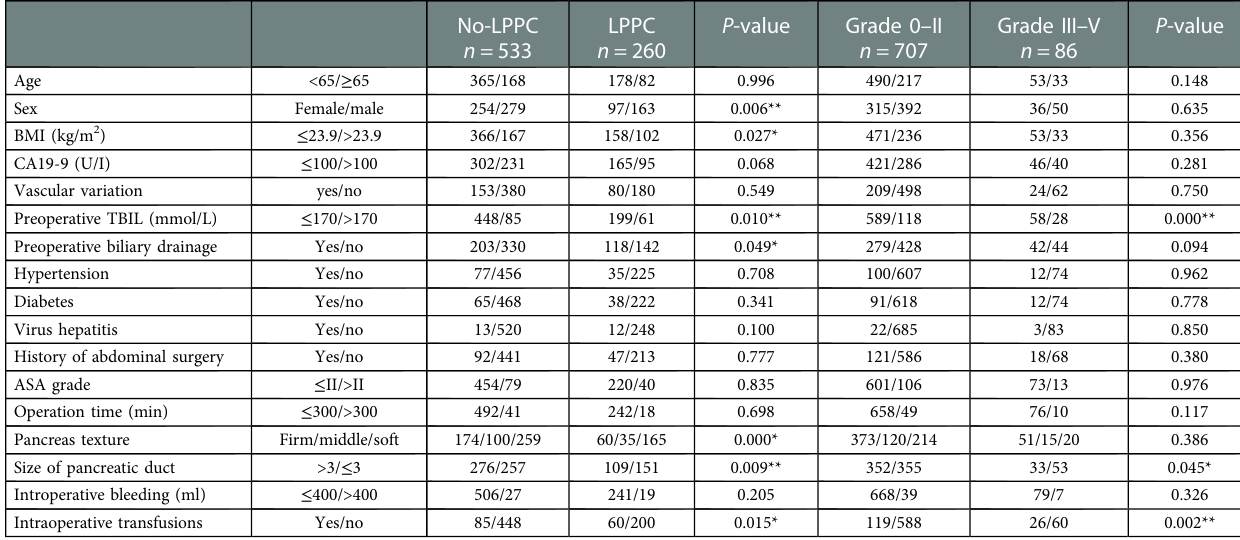
TABLE 3 Univariate analysis of postoperative complications and severe